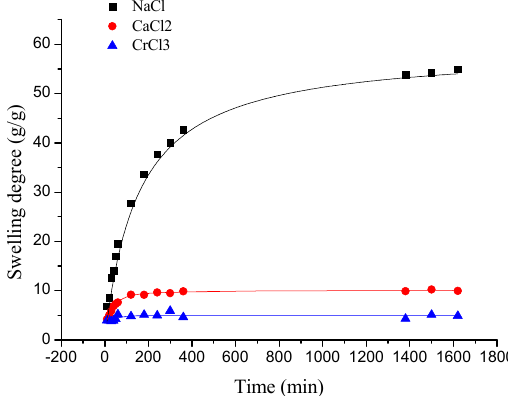
Figure 5. The swelling kinetics of γ -PGA/ ε -PL hydrogels in NaCl, CaCl 2 , and CrCl 3 solutions.